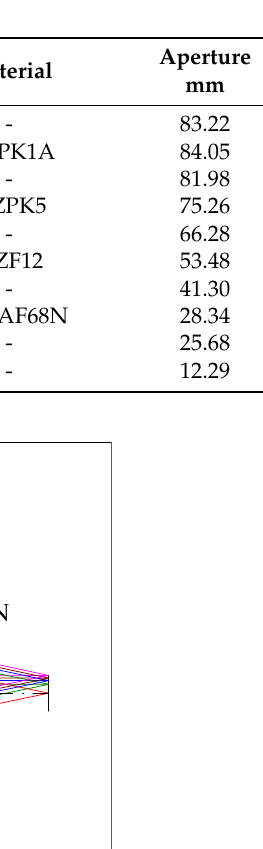
Table 1. Lens specifications.